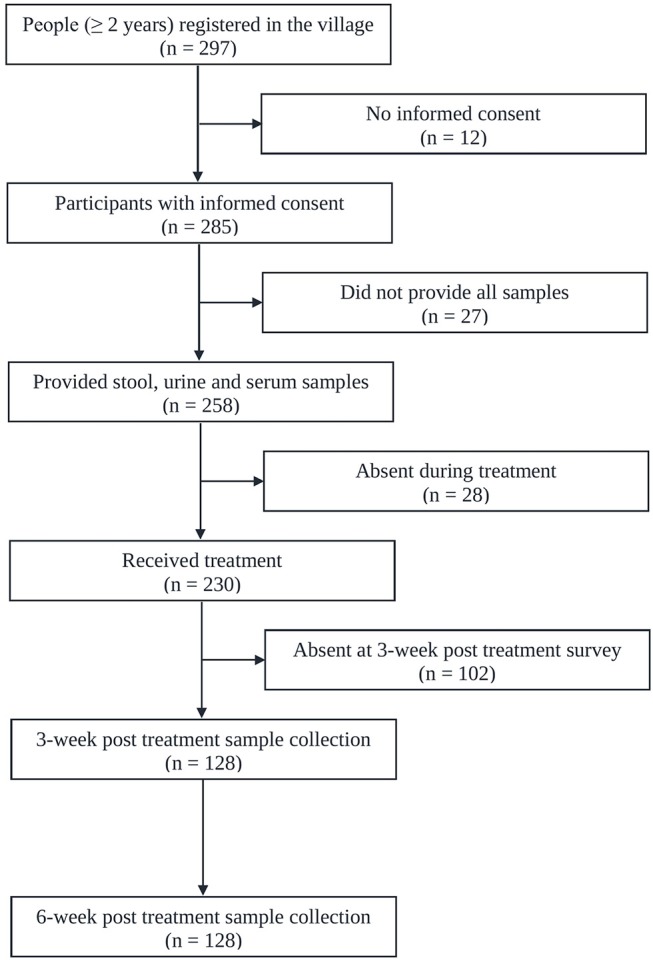
Flowchart showing study participation. Flowchart detailing the study participation and adherence of people for submitting samples for the diagnosis of S. mansoni infection before and after administration of praziquantel in Bananeiras village, Ceara, Brazil, between April and October 2013.